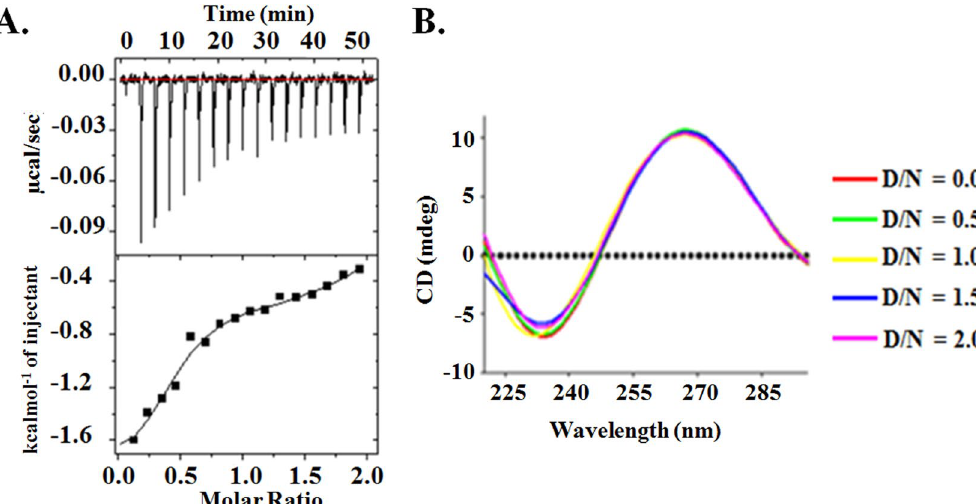
Figure 3. Isothermal Titration Calorimetry and Circular Dichroism studies. ( A ) ITC titration data (points) for Quercetin binding to Pu24T at 25 °C. Solid line represents the fitted data results from two site binding mode. ( B ) Circular Dichroism titration spectrum for free Pu24T (Red) and in the presence of Quercetin as a function of Quercetin concentration at D/N ratio = 0.5 to D/N ratio = 2.0. D = Quercetin; N =